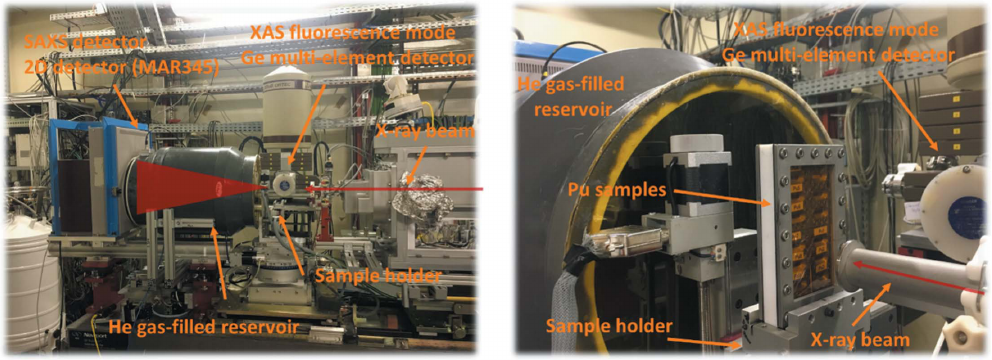
Figure 2 The MARS beamline CX3 endstation configuration to perform combined SAXS–XAS analyses. Reproduced with permission from Micheau et al. (2020) (ESI), copyright (2020) Royal Society of